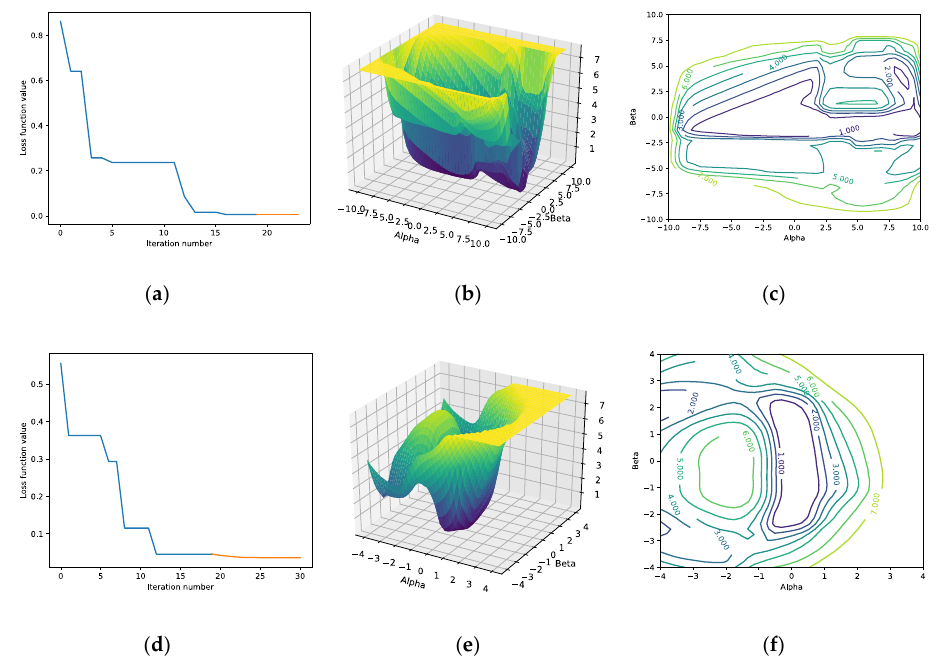
Figure 4. ( a ) FSSGD algorithm convergence when r = 10; ( b ) loss function surface visualization near the suboptimal solution, r = 10; ( c ) contour plot of the loss function, r = 10. ( d ) FSSGD algorithm convergence when r = 4; ( e ) loss function surface visualization near the suboptimal solution, r = 4; ( f ) Contour plot of the loss function, r =